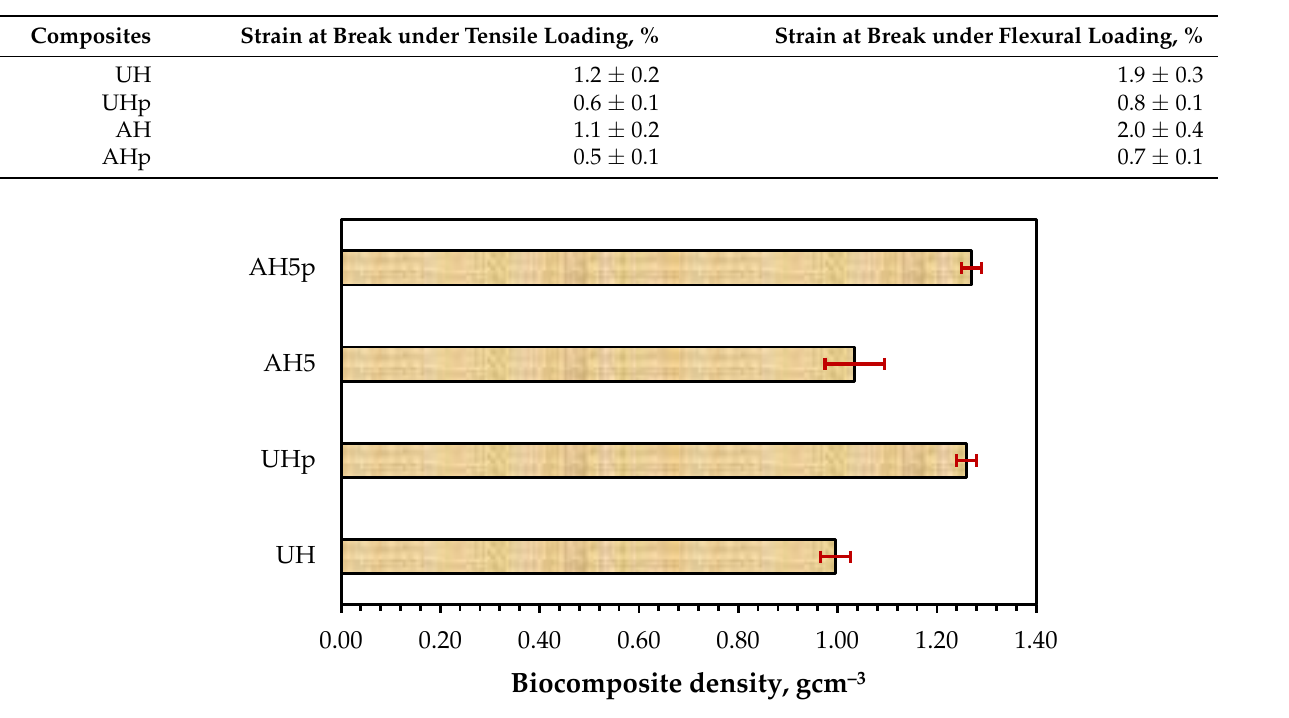
Figure 12. Density of biocomposites reinforced with 50 wt.% hemp fibers (untreated (UH), untreated with F1 (UHp), 1-h treatment with 5% alkali (AH5) and the variant with F1 (AH5p).